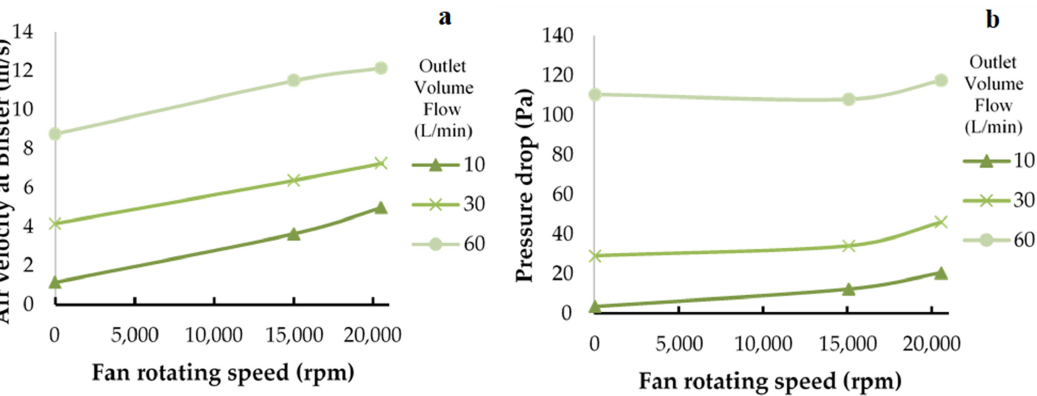
Figure 10. The relationships between fan rotating speed, ( a ) airflow velocity and ( b ) pressure drop at the blister pocket for Accuhaler with or without add-on device were determined through CFD simulation.